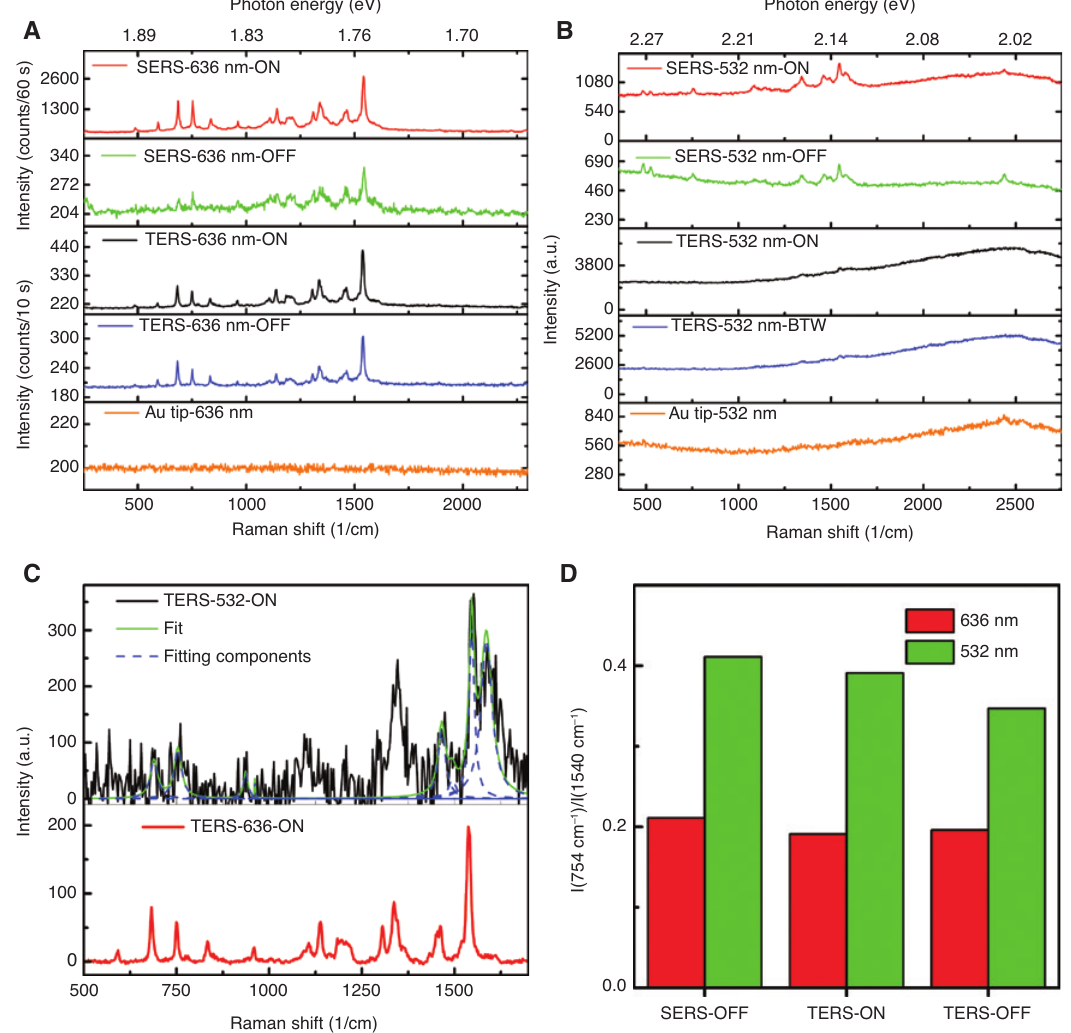
Figure 4: TERS and SERS spectra of CoPc at different excitation wavelengths. Comparison of the SERS and TERS spectra taken at (A) 636 nm excitation, and (B) 532 nm excitation. The SERS spectra in (A) are integrated for 60 s, while the TERS spectra and the one from the tip alone are taken with only 10 s integration. In (B), all the spectra are taken with 60 s integration time. (C) Comparison of the background-subtracted TERS spectra taken on top of a Au nanodisk at different excitation wavelengths. To highlight the features in the TERS spectrum at 532 nm excitation, the Raman peaks are fitted by Lorentzian functions. The green line is the cumulative fit, and dashed blue curve shows the fitting components. The solid blue line indicates the baseline. The integration time for TERS at 532 nm is 60 s, whilst it is 10 s for the one at 636 nm excitation. (D) Comparison of the intensity ratios between two Raman modes at 754 and 1540 cm − 1 , which are derived from the SERS and TERS measurements with different excitation wavelengths and locations. Each spectrum is taken by using radially polarized beam. The excitation power at the sample is ~ 200 μ W for 636 nm and ~ 150 μ W for 532 nm, respectively. “On” and “OFF” stand for positions on the top of or away from a Au nanoparticle, respectively. “BTW” indicates a position at the Au film in between the Au